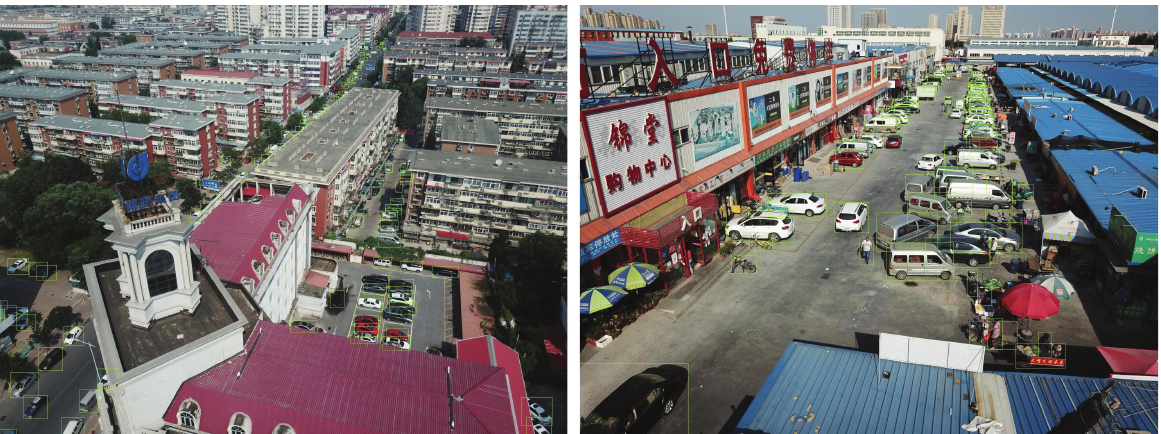
Figure 7. Images of the VisDrone